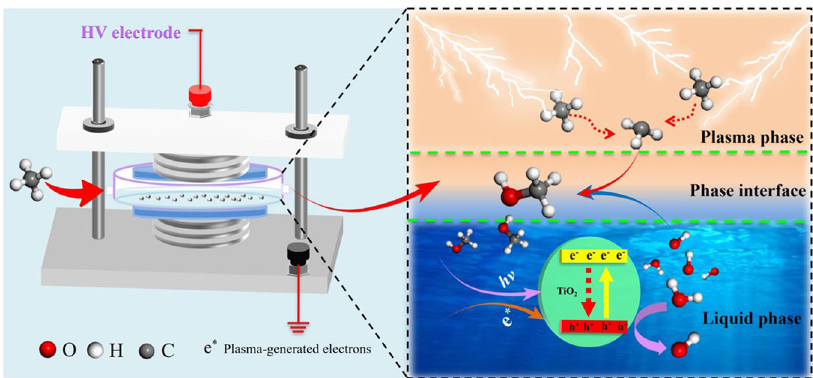
Fig. 1 Schematic of the plasma system. The reaction between CH 4 and H 2 O to afford methanol is performed in a dielectric barrier discharge (DBD)